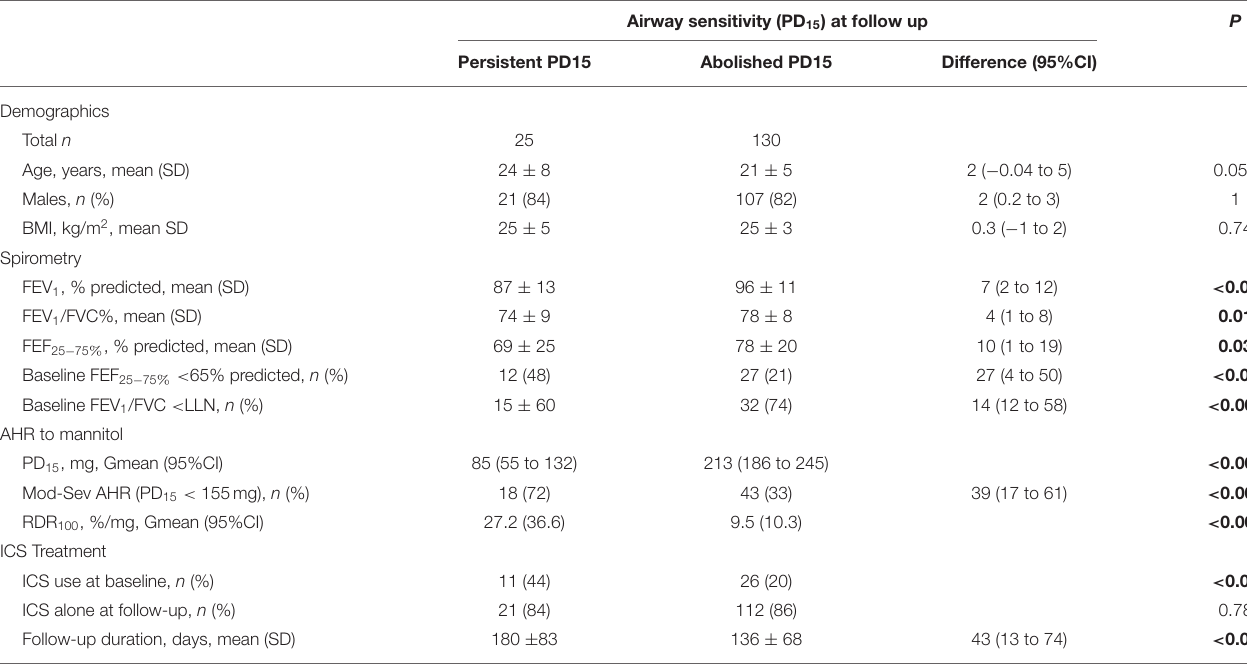
TABLE 2 | Baseline demographics, spirometry, airway sensitivity and reactivity ICS therapy at baseline visit, ICS type and duration of follow up period; Grouped based on airway sensitivity (PD 15 ) on final ICS treatment